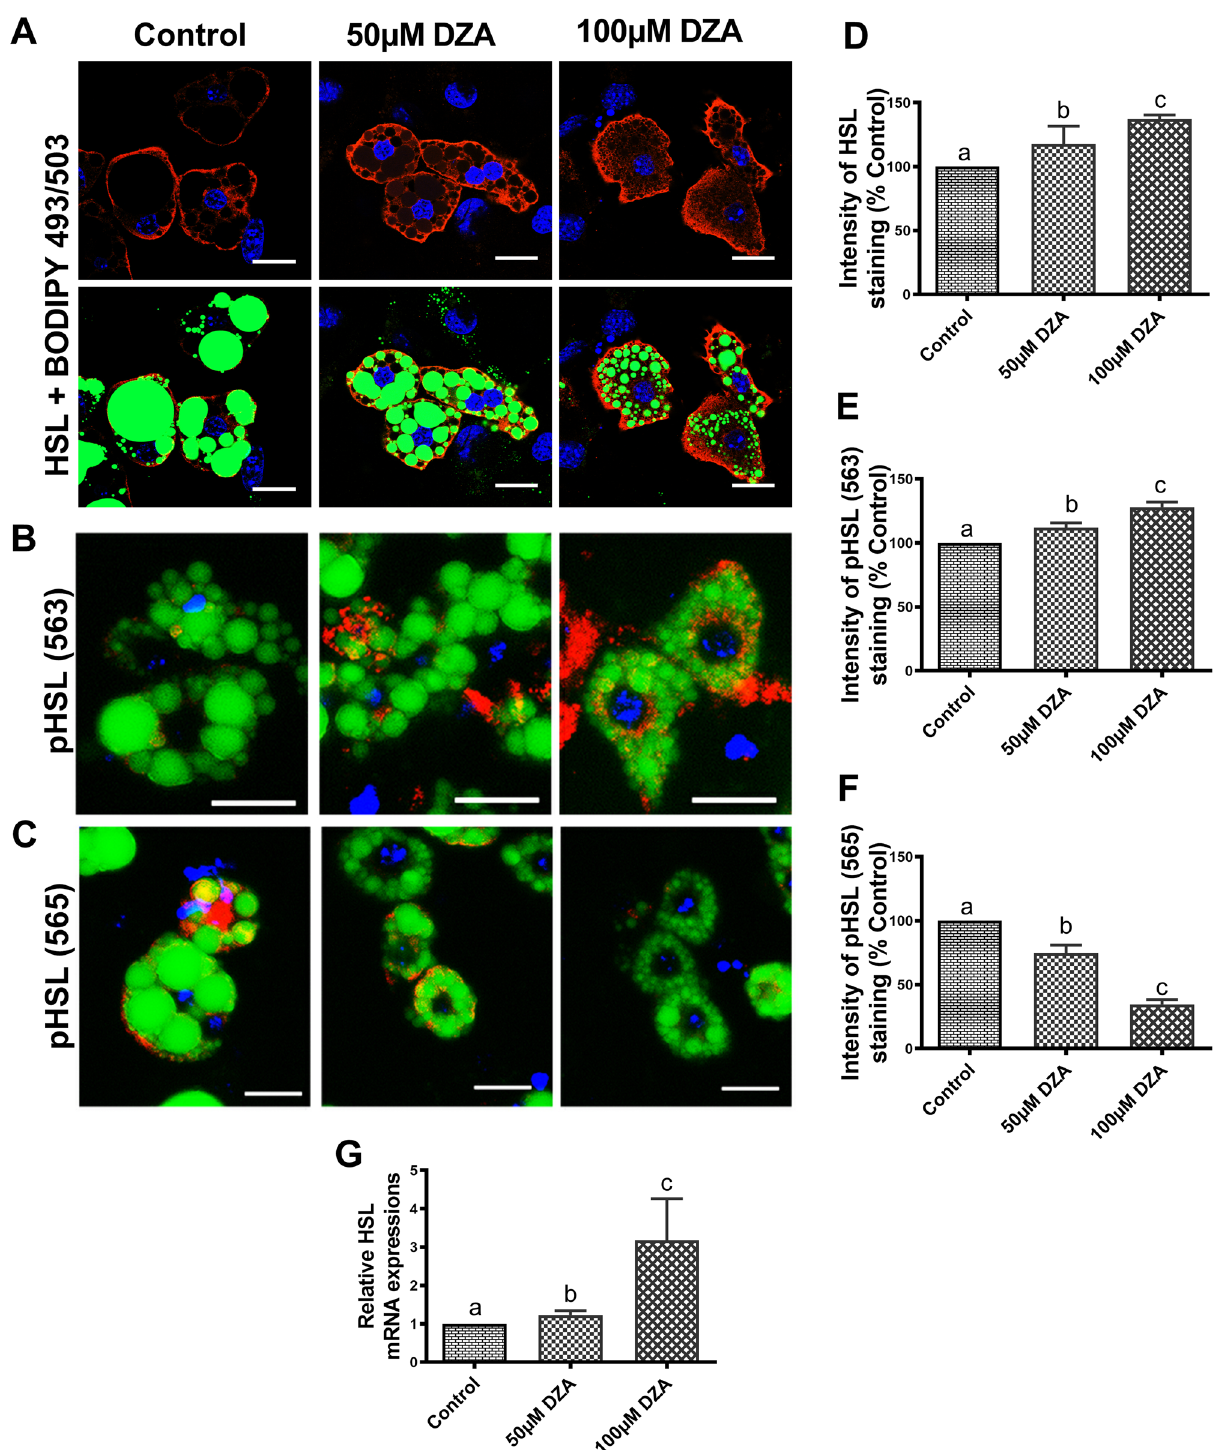
Figure 4. DZA activates HSL in 3T3-L1 adipocytes. Representative immunofluorescence images of ( A ) total HSL ( B ) pHSL-Ser(563), and ( C ) pHSL-Ser(565) in BODIPY 493/503 and DAPI stained control and DZA- treated 3T3-L1 adipocytes (Scale bar—20 µm). The fluorescence intensity of ( D ) HSL, ( E ) pHSL-Ser(563) and ( F ) pHSL-Ser(565) in DZA-treated cells normalized to % of control cells, n = 4 experiments; Images (confocal microscope—Panel A; Keyence BZ-X810 florescence microscope—Panels B and C) of 22 random cells from each treatment group per experiment were captured and analysed. ( G ) Relative HSL mRNA levels in control and DZA-treated 3T3-L1 adipocytes (n = 5). Data are presented as the mean ± SEM; values not sharing a common letter significantly differ from each other at p ≤